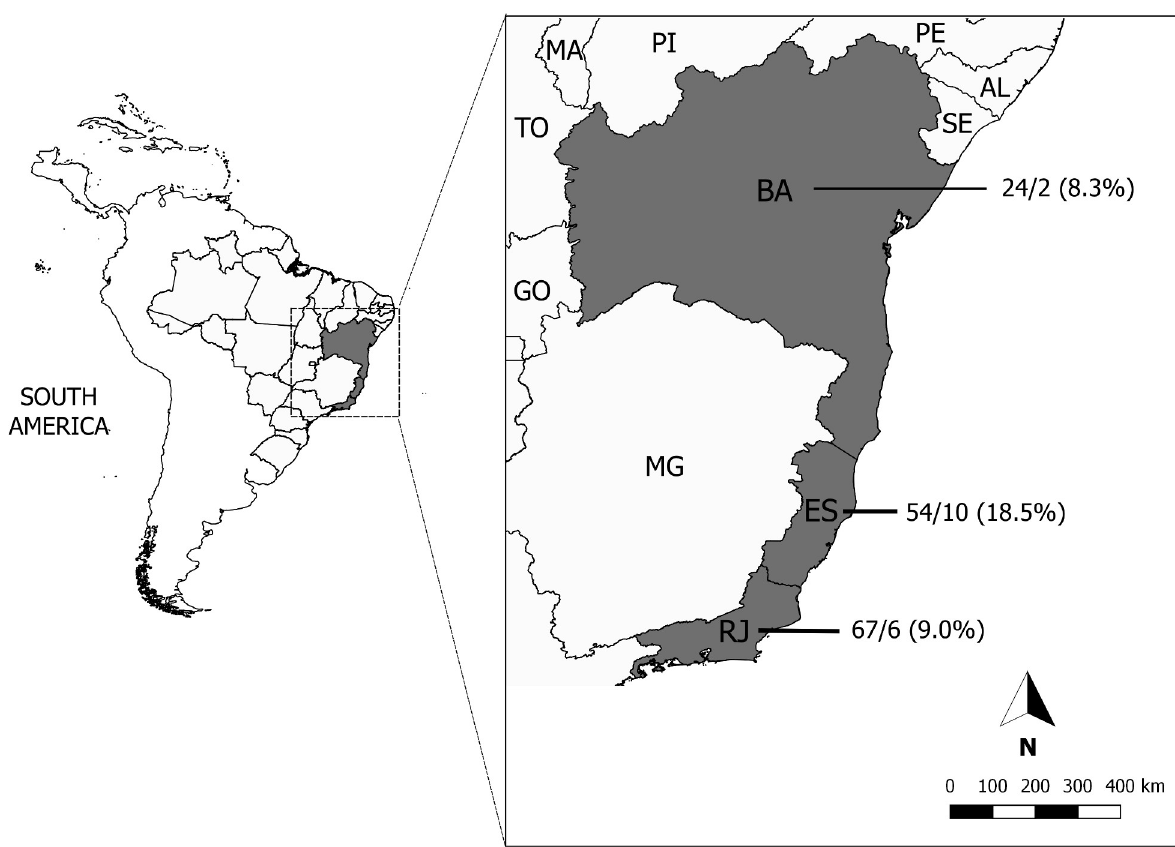
Fig 1. Distribution of T . gondii seroreactive animals per state. Data showed on the map is represented as follows: total number of animals surveyed per state/number of seroreactive animals (percentage of positive animals per state).